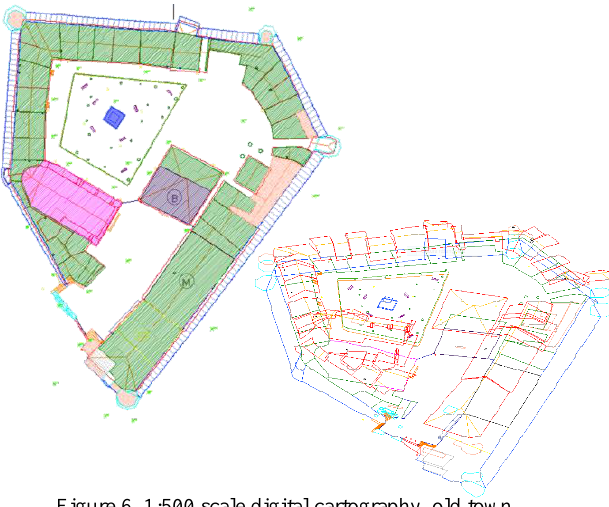
Figure 6. 1:500 scale digital cartography, old town